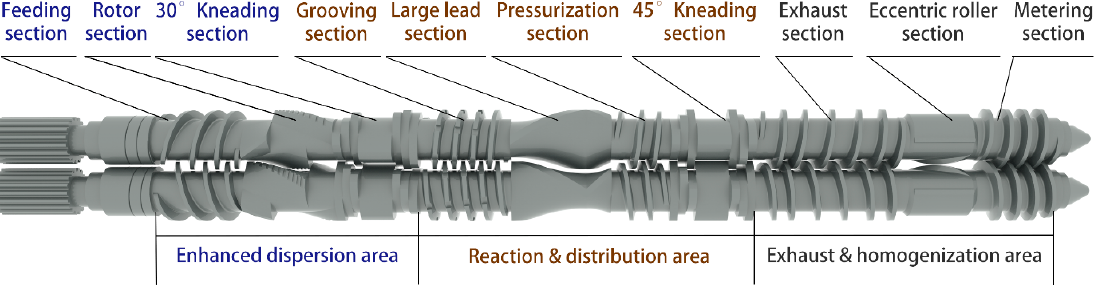
Figure 4. 3D modeling diagram of the reverse meshing reaction mixing twin rotors.